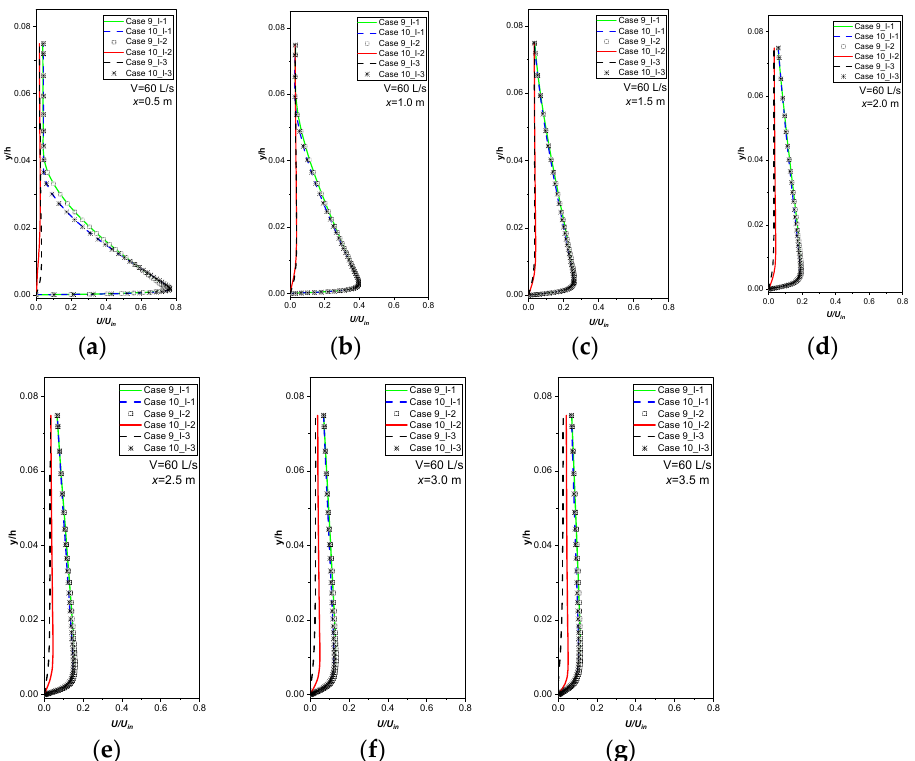
Figure 7. ( a – g ) Show the velocity change along the centerline of the floor for all evaluated cases with V = 50 L/s at x distances 0.5–3.5 m.